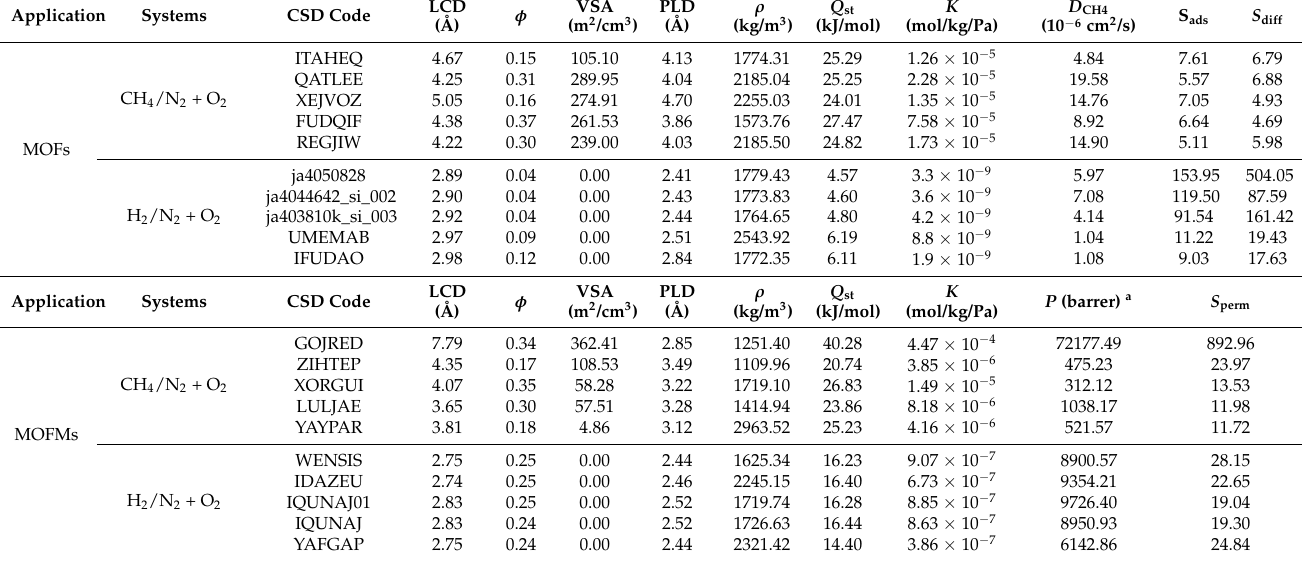
Table 2. Best MOFs and